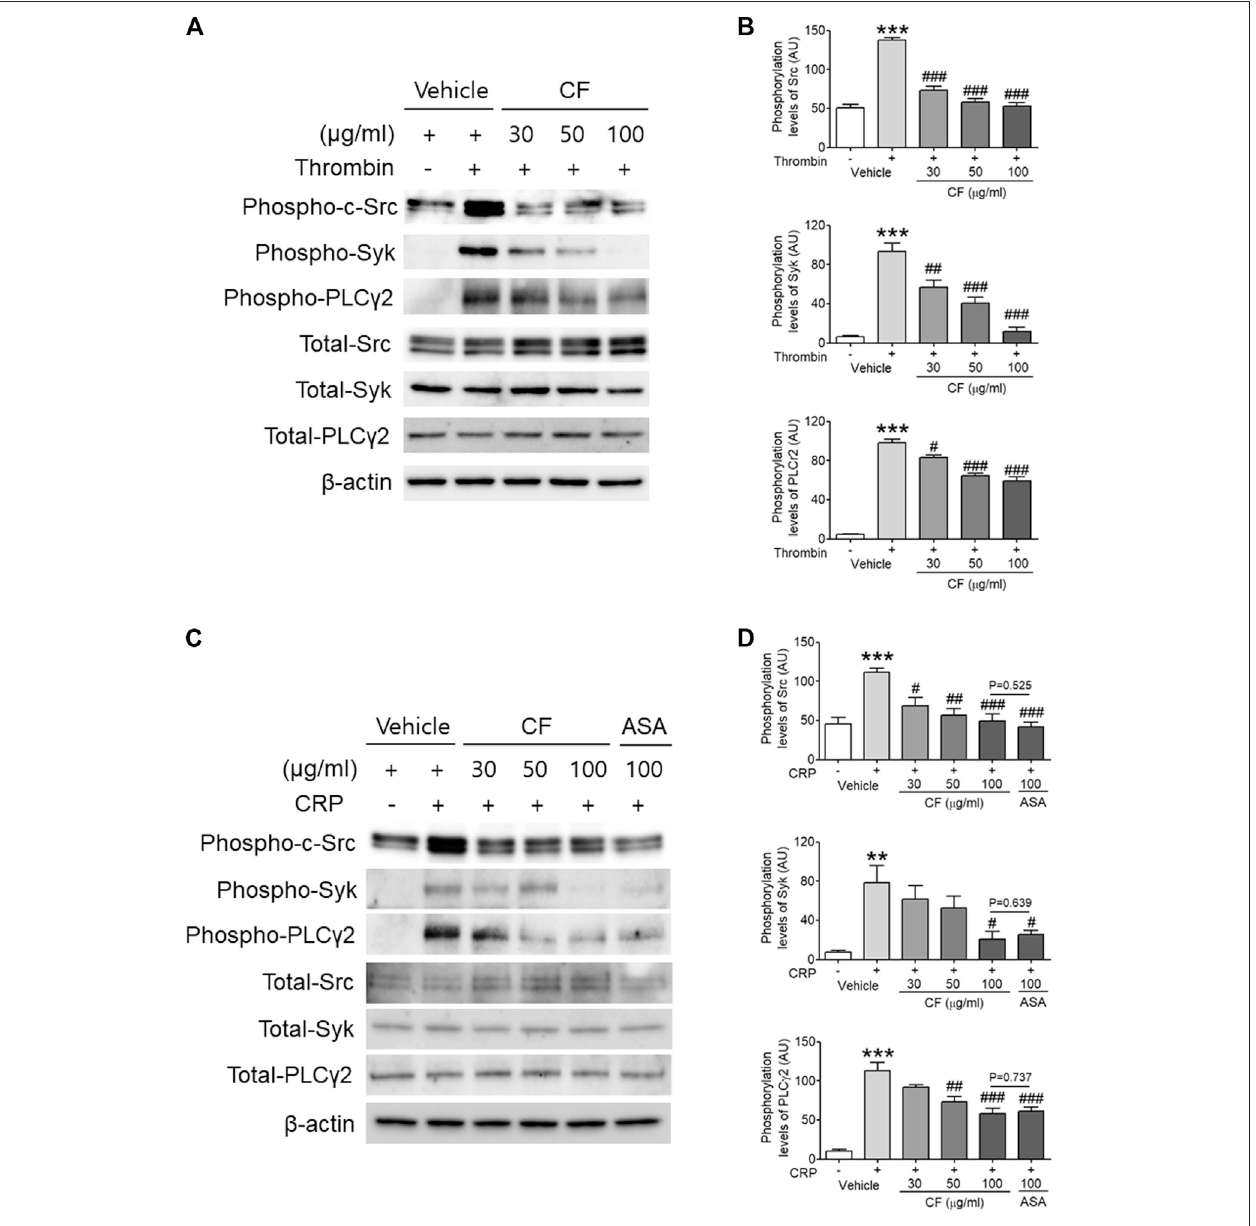
FIGURE 4 | C.fragile attenuatedphosphorylationofc-Src,Syk,PLC γ 2,PI3K,AKT,p38,andERKafterthrombinandCRPstimulation.Mouseplateletswerepre-treatedwith variousconcentrationsof C.fragile (30,50,and100 μ g/ml),andstimulatedwith0.025 U/mlThrombin (A,B) .Insomeexperiments,washedplateletswerepretreatedwith C.fragile (30, 50,and100 μ g/ml)orASA(100 µM)andthenstimulatedwith0.2 μ g/mlCRP (C – F) .Equalamounts(30 µg)ofcelllysateproteinwereimmunoblottedtodeterminespeci fi cinhibitionof c-Src,Syk,PLCr2,PI3K,AKT,p38,andERKphosphorylation.Representativeblots (A,C,E) .Quantitativegraphs (B,D,F) .Datarepresentthemean ± SD( n (cid:2) 5).**: p < 0.01and ***: p < 0.001 vs. vehicle control (unstimulated) after Student ’ s t -test, and. #: p < 0.05, ##: p < 0.01, and ###: p < 0.001 vs. vehiclecontrol (stimulated) after ANOVAand Turkey ’ s test.